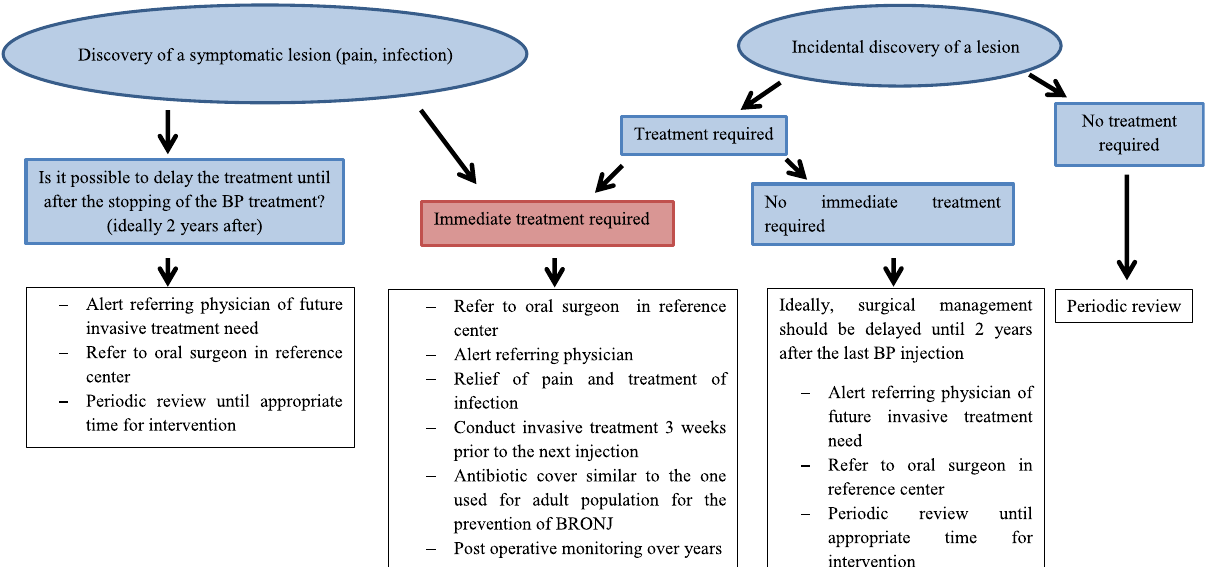
Fig. 6. Surgical management pathway for pediatric patients receiving or having received BP (after Bhatt et al.